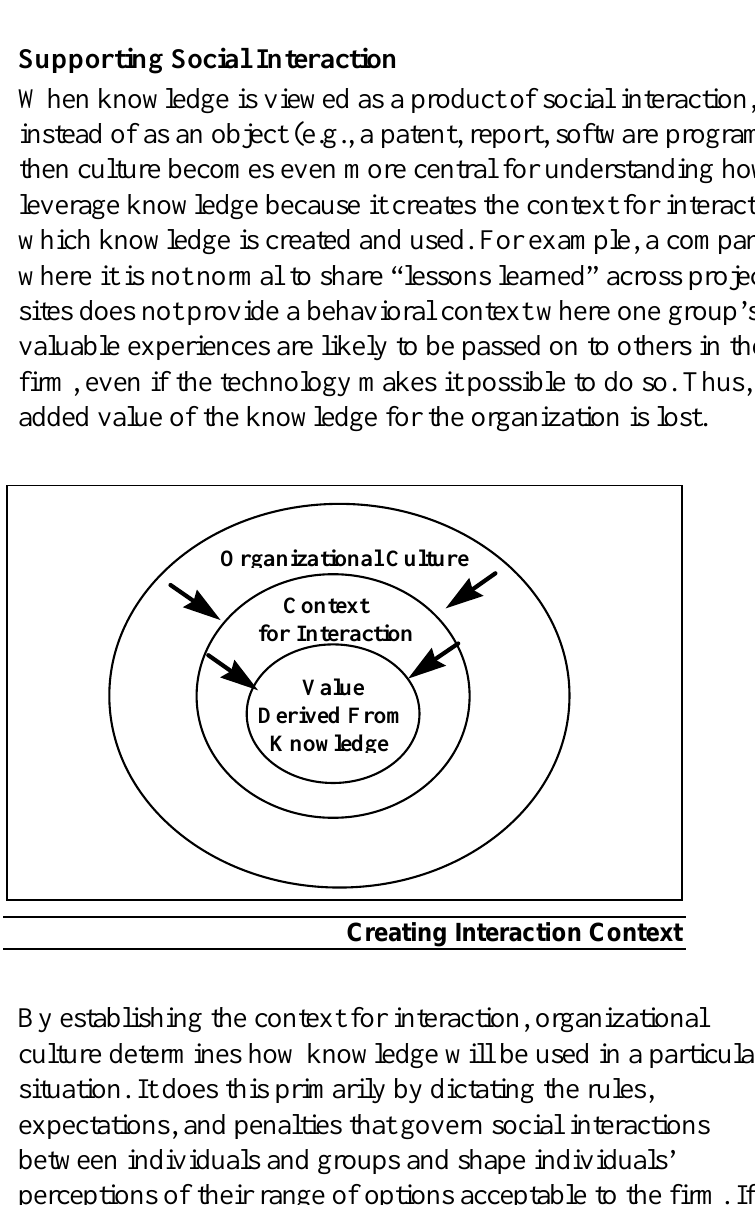
Creating Interaction